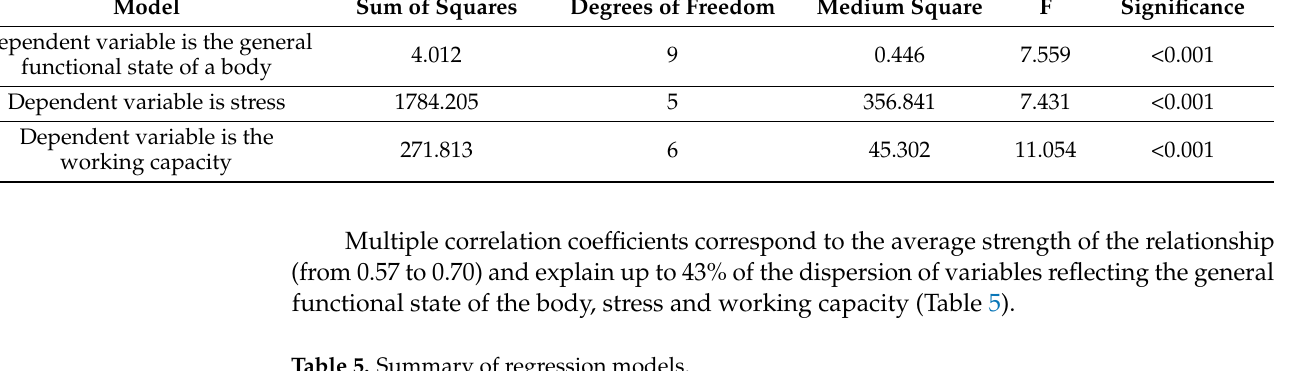
Table 5. Summary of regression models.